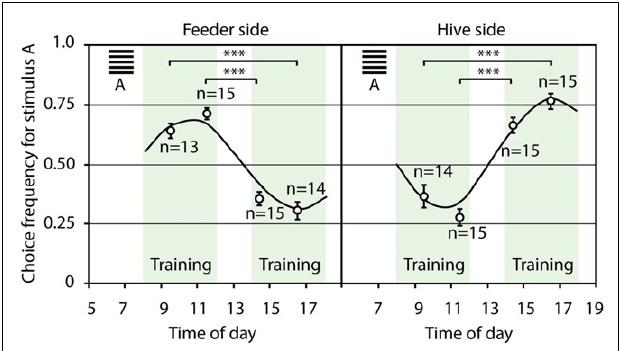
FIGURE 13 |Time and task as contextual cues. During training, the horizontal grating stimulus in the maze and the vertical grating at the hive were rewarded in the morning, whereas in the afternoon, the vertical grating in the maze and the horizontal grating at the hive were rewarded. Shown are the choice frequencies for the horizontal grating stimulus.The trained bees reversed their stimulus preference in the maze and at the hive entrance following midday breaks, as well as overnight breaks. At the same time, the bees reversed their stimulus preference within a few minutes, and made opposing decisions between foraging and homing.The modulation of the average choice frequency, with reference to the horizontal grating, could be approximated very well by a sinusoidal curve with a frequency of 0.52, i.e., a period of 12h.The phase of the sinusoidal curve at the hive was shifted 180˚ with reference to the feeder. ***Denotes p < 0.001. Modified from Zhang et al.